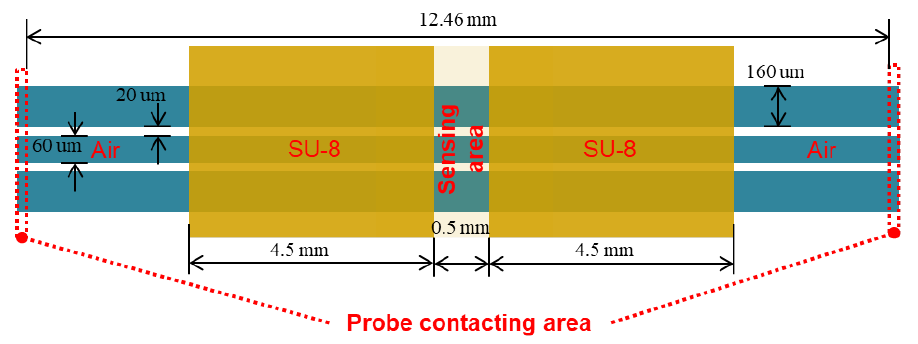
Figure 2. The structure and dimensions of the designed CPW TL sensing